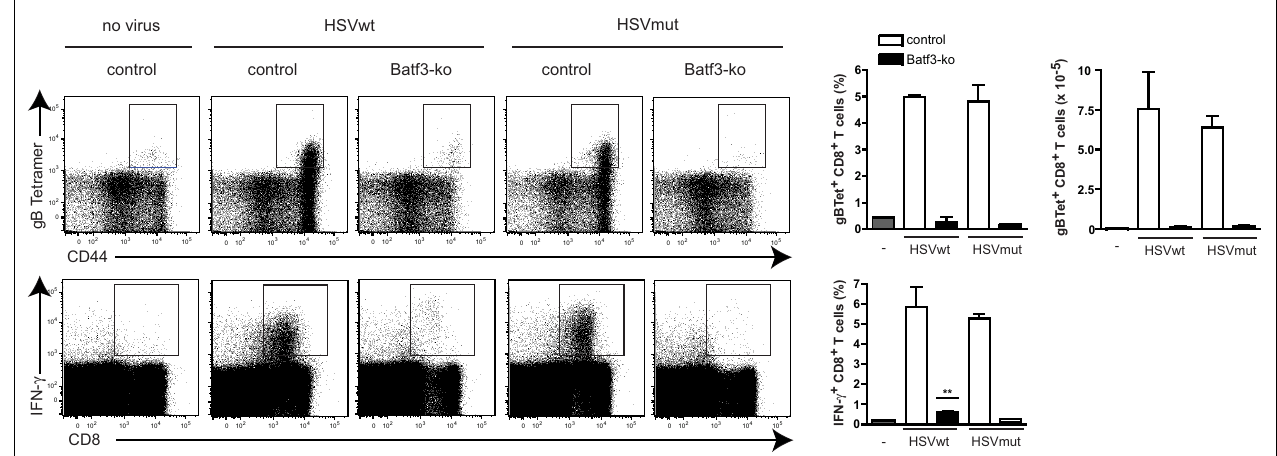
panel). Dot plots are gated on CD8 + T cells (upper panel) or lymphocytes (lower panel) first (not shown). Data shown as bar graphs are mean ± SEM from n = 3 mice per group. (** P = 0.0018 as compared to unstimulated control). Open bars represent C57BL/6-wild type mice and filled bars represent Batf3-ko mice.This experiment has been repeated twice with similar